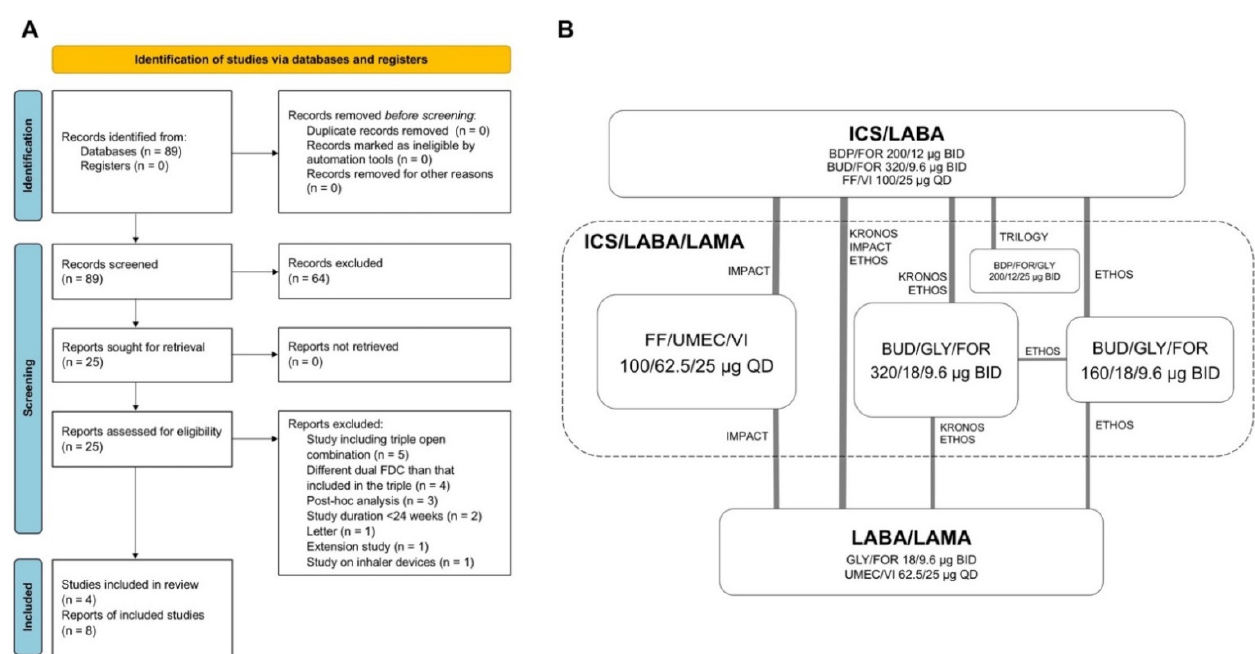
Figure 1. PRISMA 2020 flow diagram ( A ) and diagram displaying the Bayesian network across the treatments ( B ). The links between the nodes indicate the direct comparisons between pairs of treatments; the thickness of lines is proportional to the number of patients comparing pairs of treatment head-to-head, and the area of the boxes is proportional to the number of patients receiving the same treatment. BDP: beclomethasone dipropionate; BID: bis in die, twice daily; BUD: budesonide; FDC: fixed-dose combination; FF, fluticasone furoate; FOR: formoterol fumarate; GLY: glycopyrronium bromide or glycopyrrolate; ICS: inhaled corticosteroid; LABA: long-acting β 2 -adrenoceptor agonist; LAMA: long-acting muscarinic antagonist; PRISMA: Preferred Reporting Items for Systematic Reviews and Meta-Analyses; QD: quaque die, once daily; UMEC: umeclidinium bromide; VI: vilanterol.